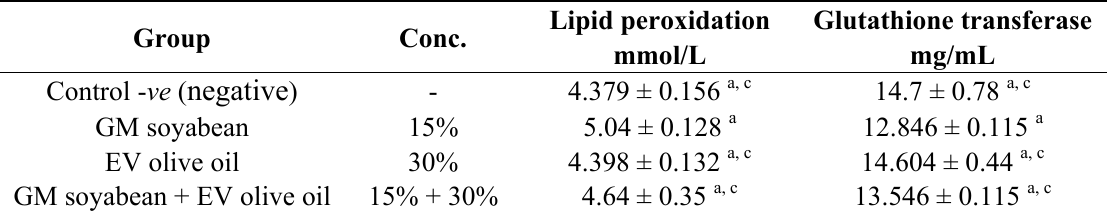
Table 3. Mean values of serum antioxidant enzymes in rats fed diets containing soyabean, olive oil or their combination ( n = 10). Significant at p < 0.05 using ANOVA test a, b, c,… Significantly different between two comparison groups within the same litter and column using Duncan Multiple Range test at p < 0.05.